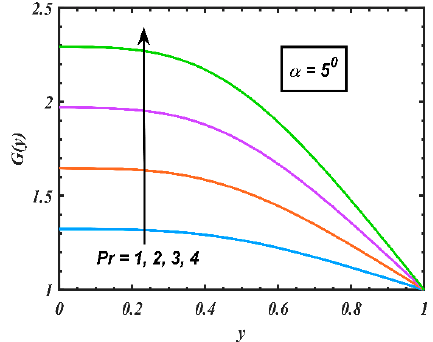
Figure 3. Variation of G(y) in diverging channel for Pr = 1, 2, 3, 4 and Ec = 0.5, Re = 100, α = 5 0 , H = .